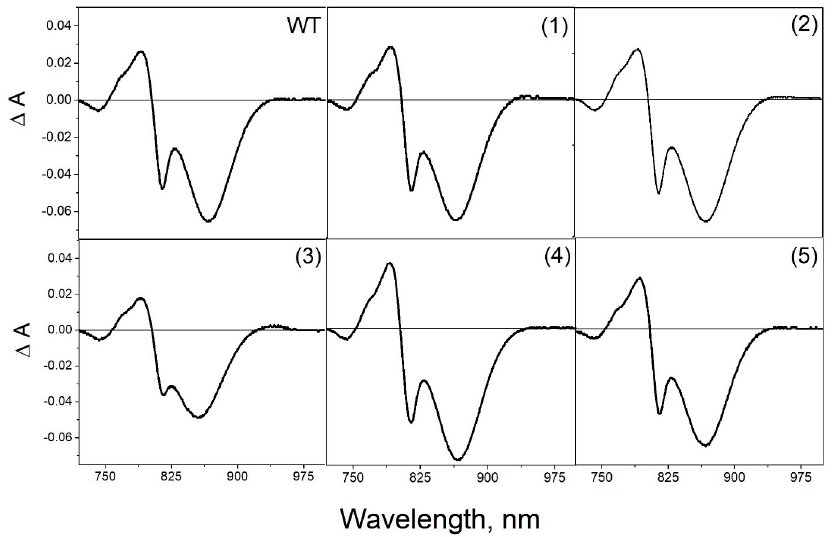
Figure 5. Differential (light minus dark) absorption spectra of wild-type RC C. sphaeroides and mutant reaction centers: (1) V(M84)C+G(L278)C, (2) A(L53)C+I(L64)C, (3) A(L172)C+L(L246)C, (4) A(L37)C+S(L99)C, and (5) G(M19)C+T(L214)C. Spectra were measured at room temperature and normalized at the Q Y H absorption band.